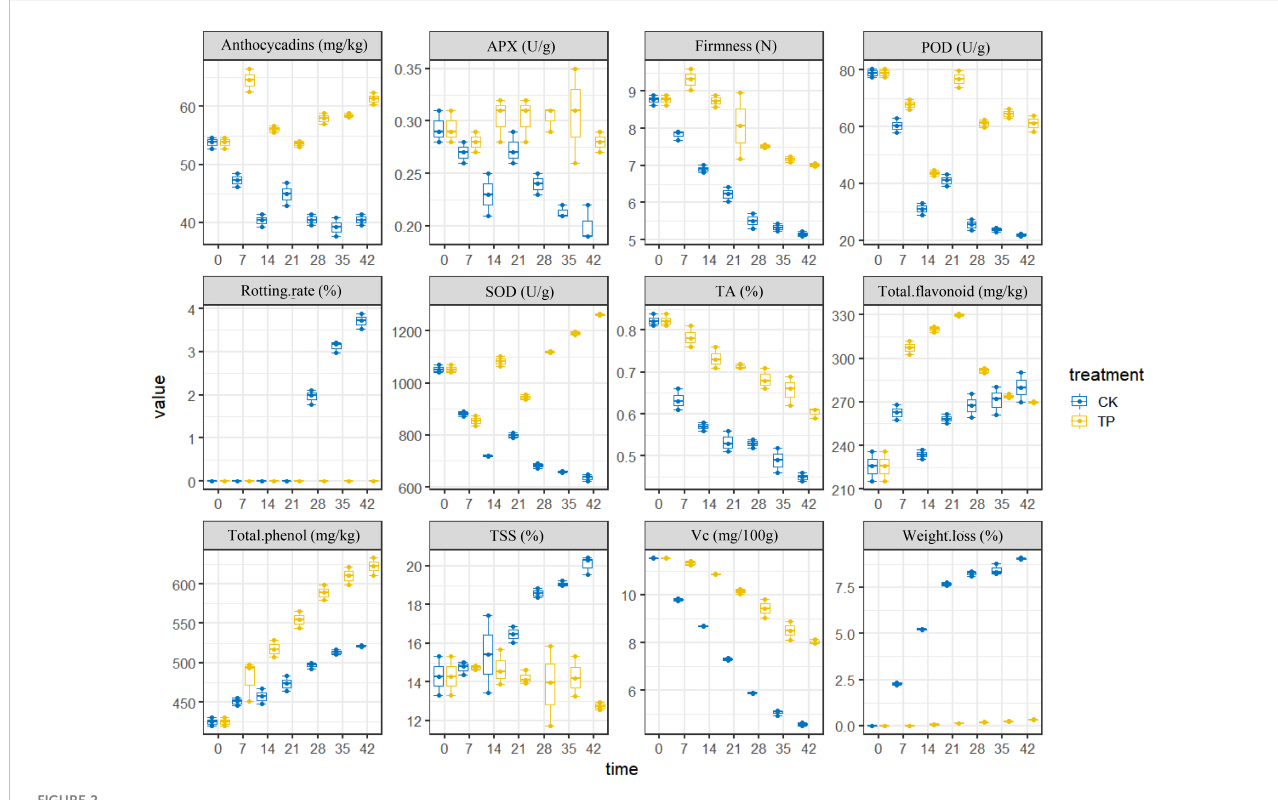
FIGURE 2 The 12 physiological characteristics of sweet